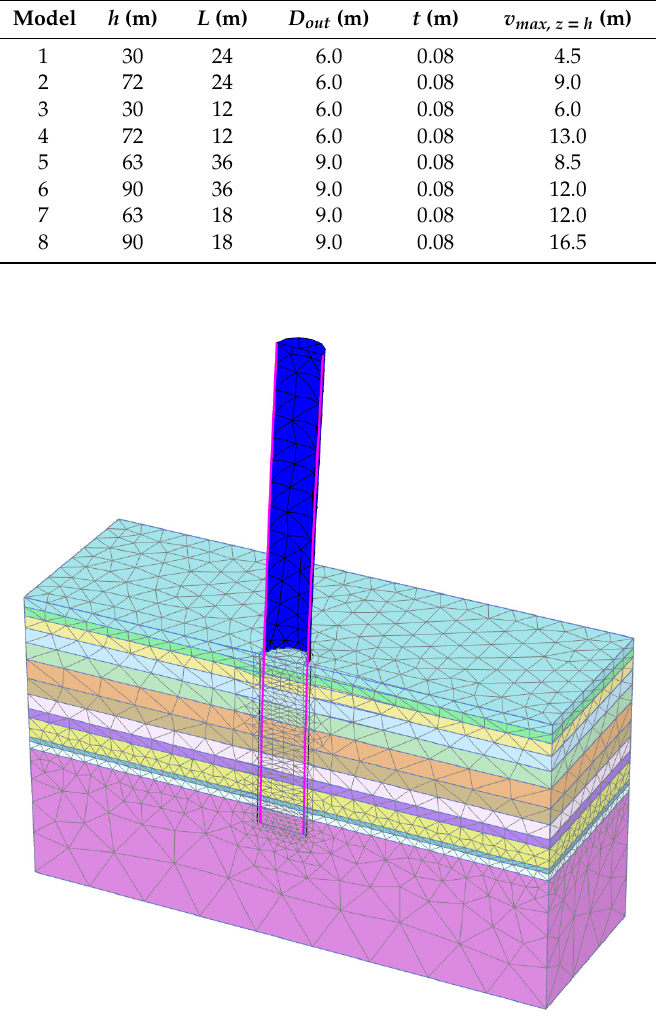
Figure 6. Deformed mesh of Model 5.